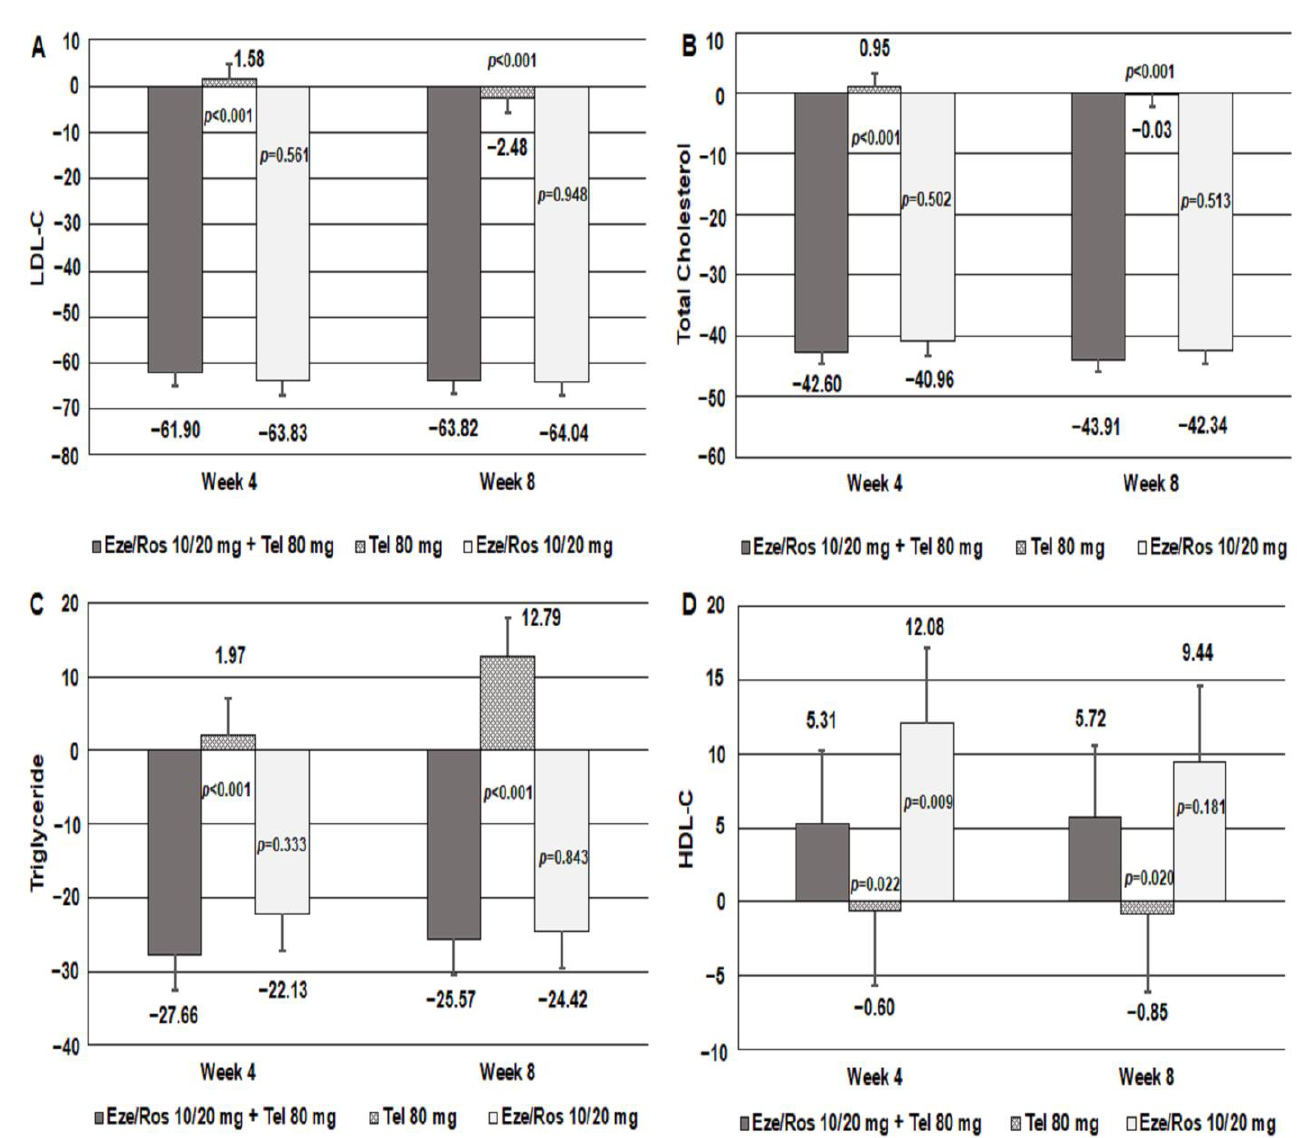
Figure 3. Secondary outcomes at weeks 4 and 8. ( A ) LDL-C, ( B ) Total Cholesterol, ( C ) Triglyceride, ( D ) HDL-C.